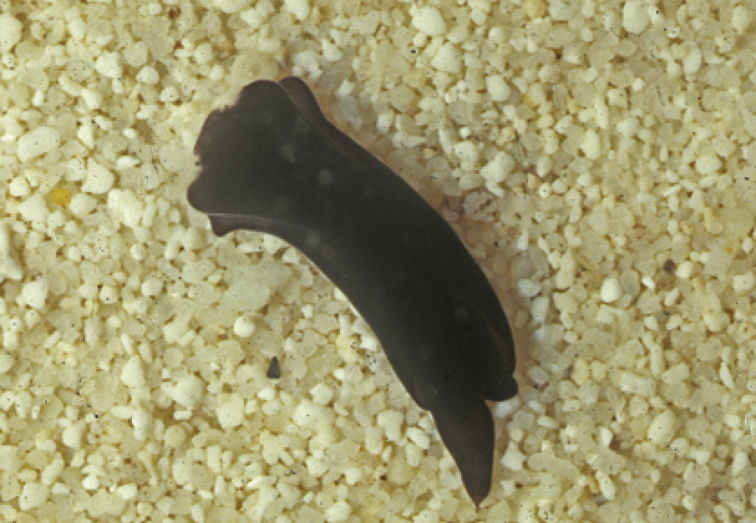
Chelidonura sandrana, 7 mm, Maldives, photo: J Hinterkircher.